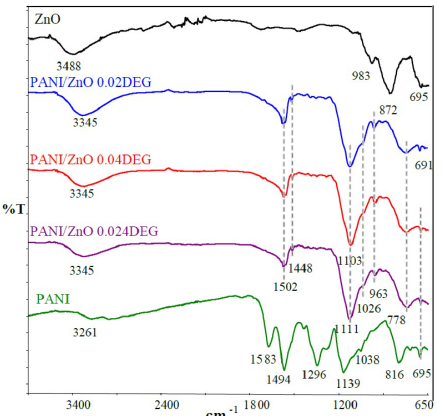
Figure 1. Fourier transform infrared (FTIR) spectra of pure polyaniline (PANI), zinc oxide (ZnO), and PANI/ZnO composites.